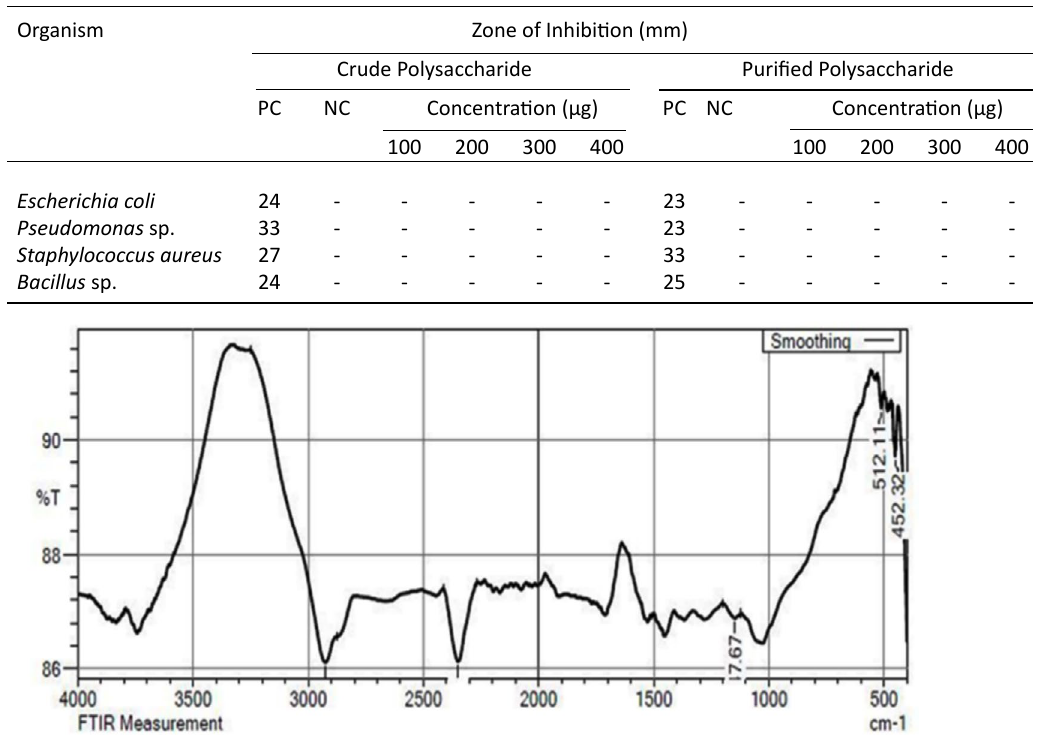
Fig. 3. FTIR spectrum of purified polysaccharide.